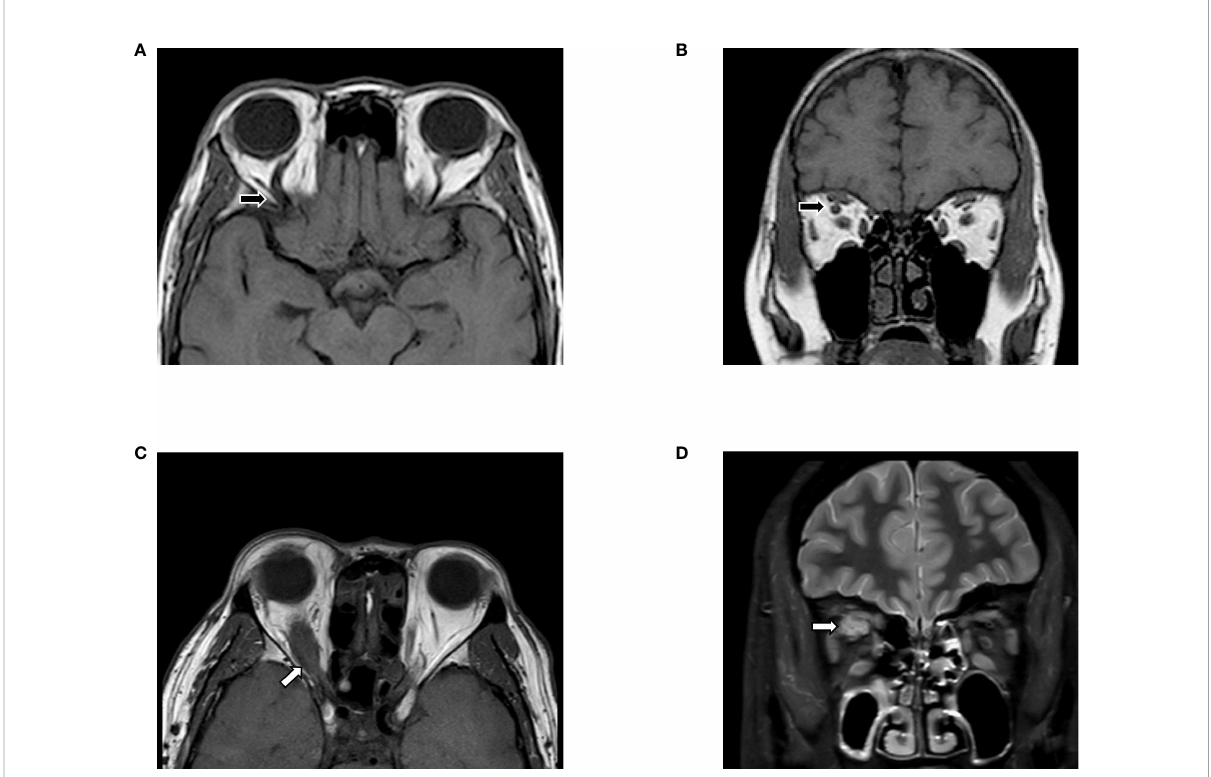
FIGURE 1 Differential diagnosis based on MRI. (A, B) Slightly enlarged EOMs were shown in T1WI, with the unilateral, augmented superior ophthalmic vein (black arrows). Features indicated carotid-cavernous fi stulas instead of GO, which need to con fi rm via digital subtraction angiography (DSA). (C, D) MRI images suggested Imbalanced exophthalmos and the apparent swelling of superior rectus in the right eye. Meanwhile, in T2FS, increased signal of EOMs, combined with the tendon involved (white arrows) enlargement in superior rectus suggested orbital myositis. The fi gure is